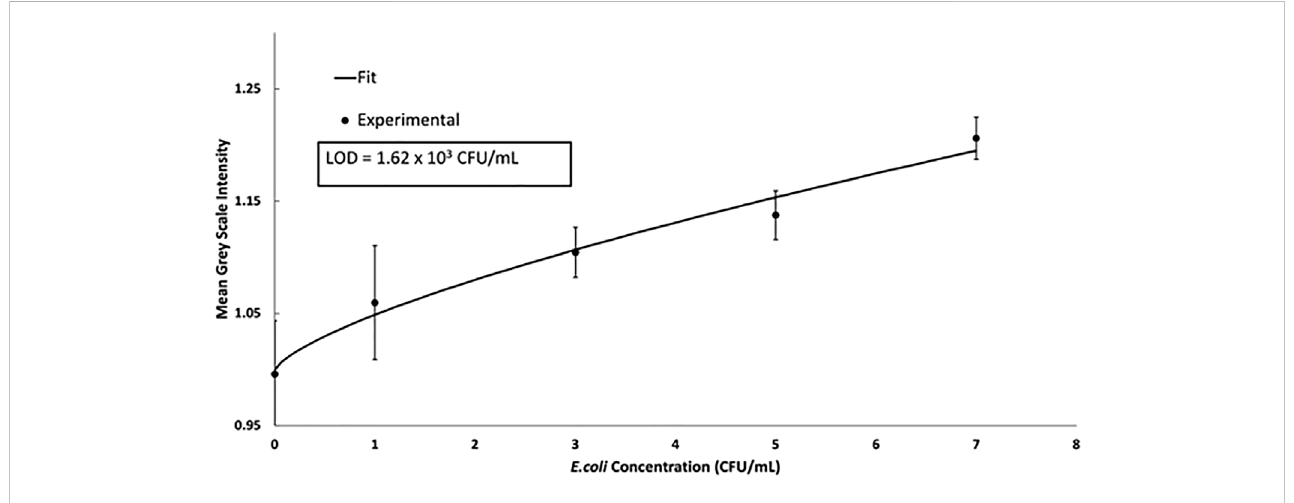
FIGURE 6 4PL logistic curve of the sandwich E. coli assay at varying